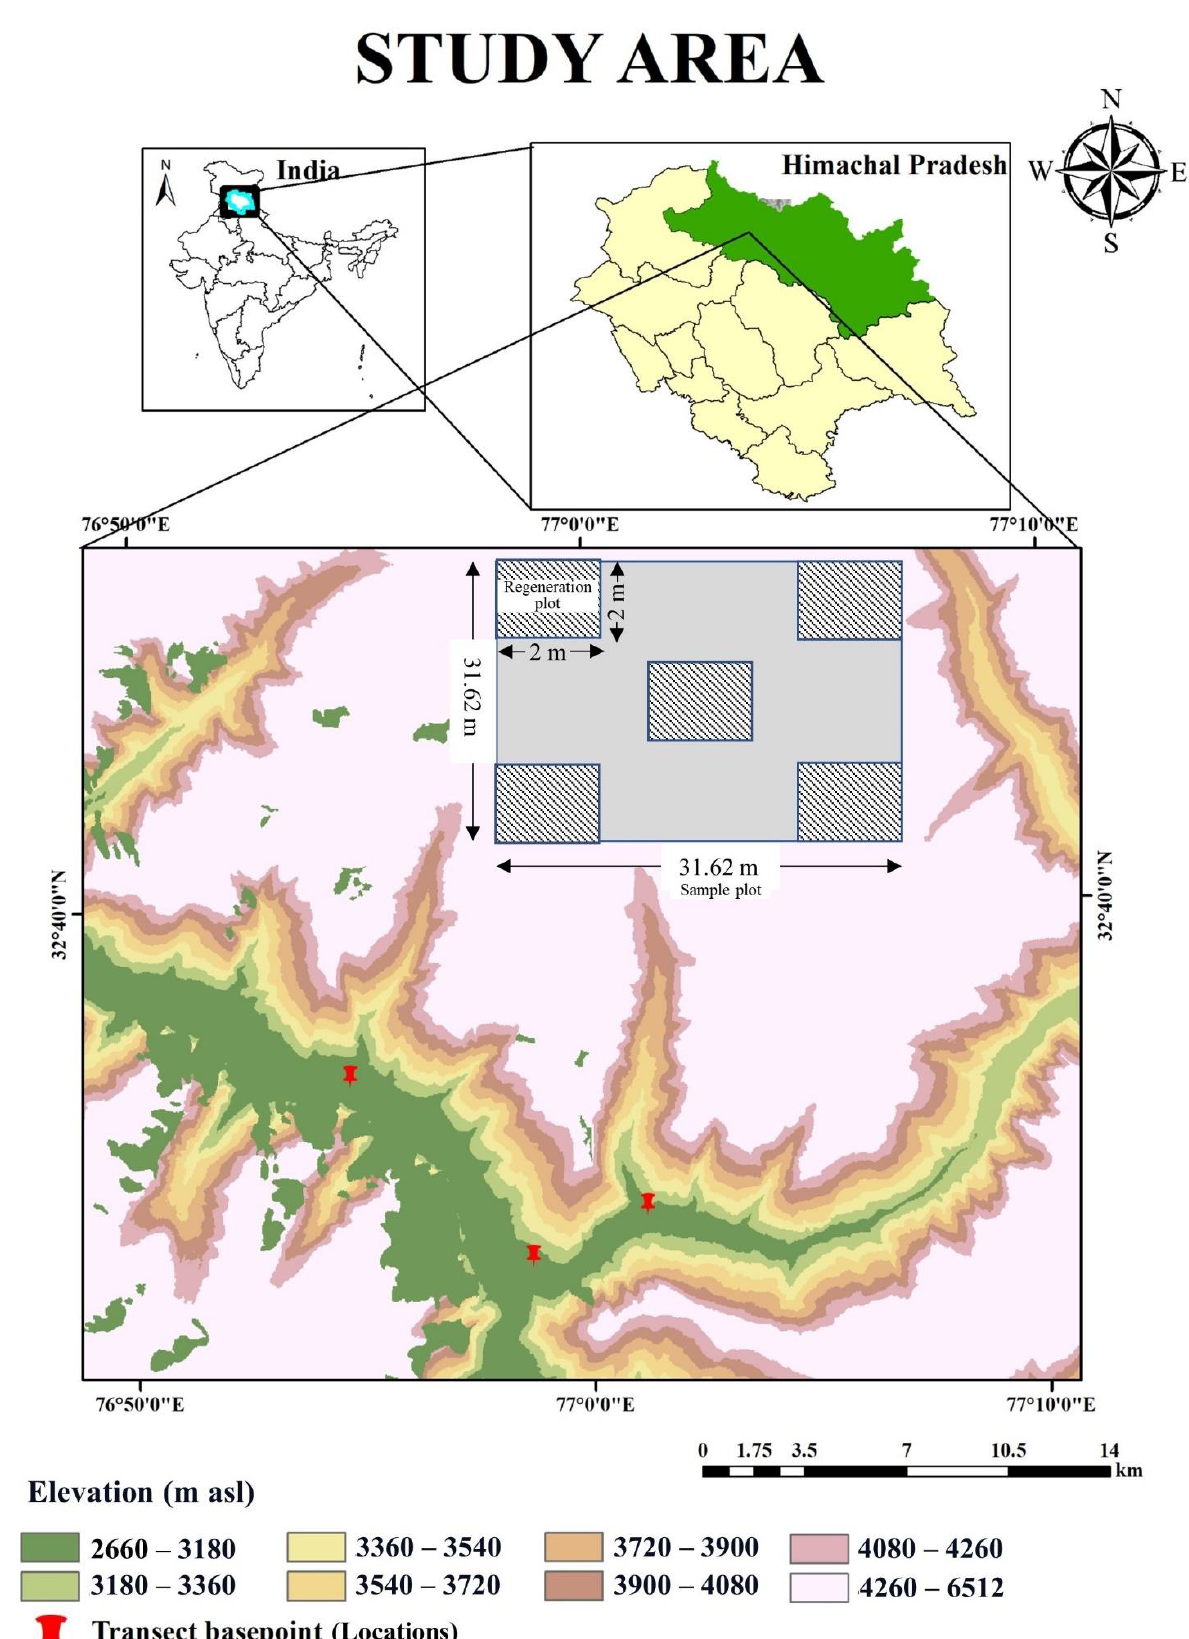
Figure 1. Map of the study area.